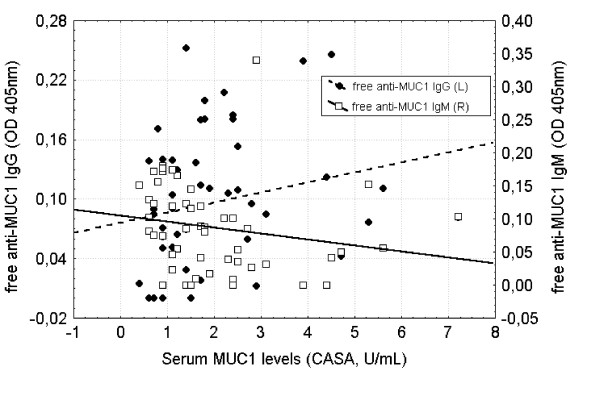
Correlation between serum MUC1 levels measured by Cancer Associated Serum Assay (U/mL) and free anti-MUC1 antibodies. Serum MUC1 levels were plotted in abscises against anti-MUC1 IgG Abs (left coordinates) and IgM Abs (right coordinates). A negative correlation between serum MUC1 levels versus anti-MUC1 IgM Abs (τ = -0.266; p < 0.05) and a positive correlation between serum MUC1 levels and IgG Abs are observed (τ = 0.194; p < 0.05).